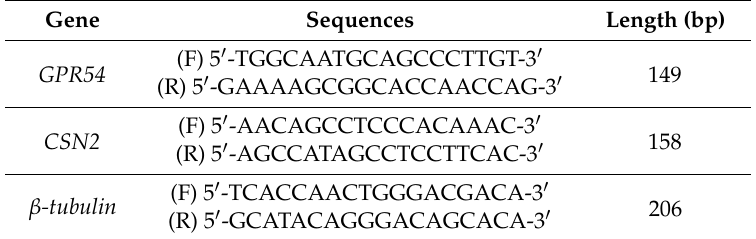
Table 1. Sequences of the Primers Used to Amplify GPR54 , CSN2 and β -tubulin .